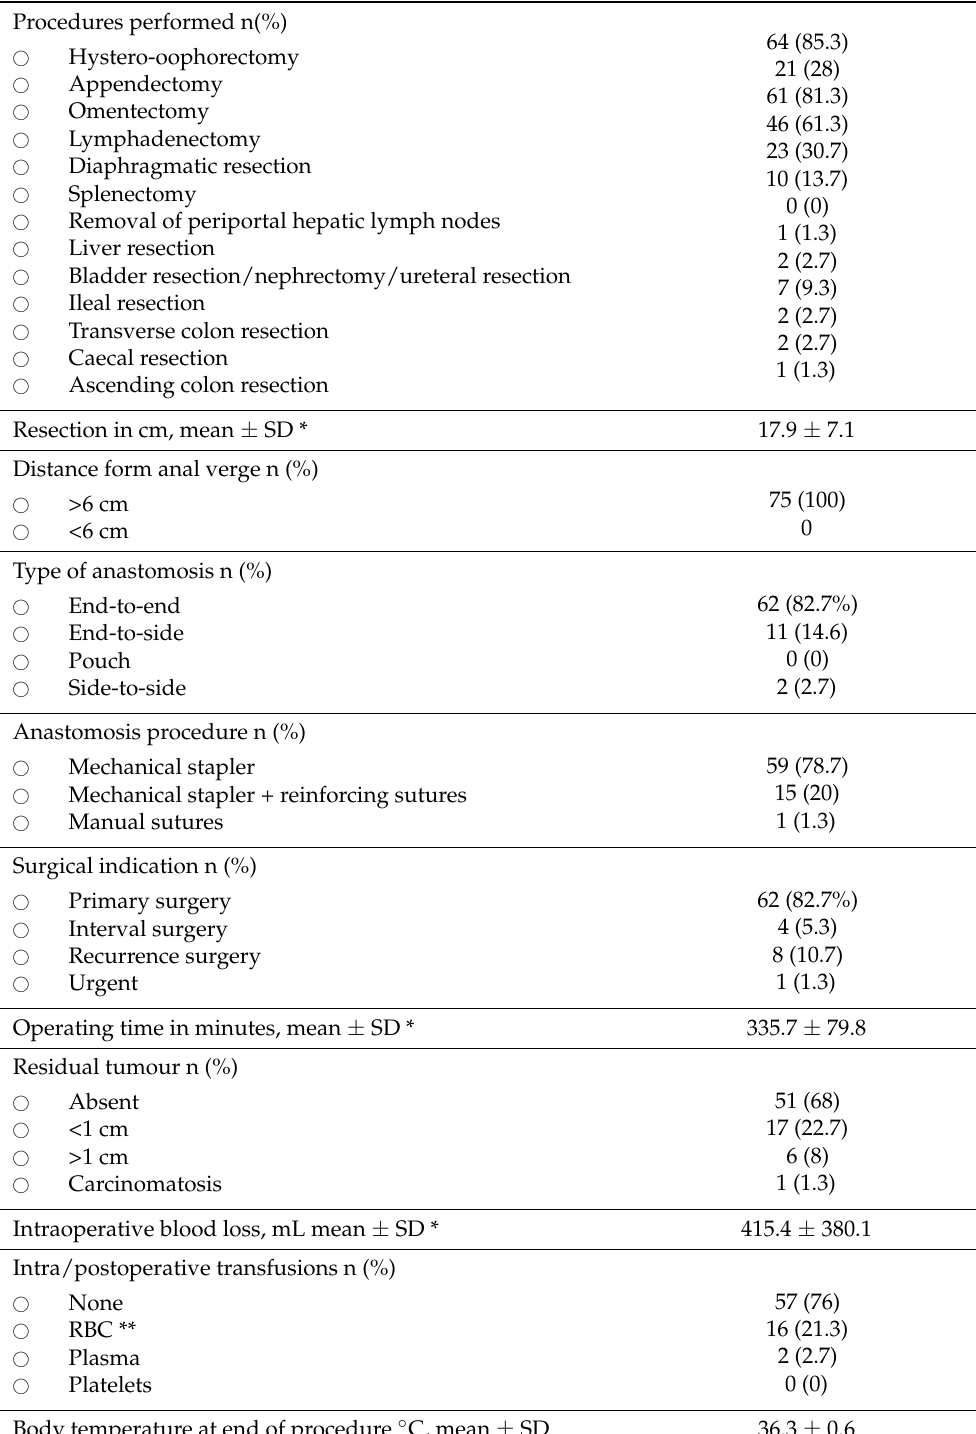
Table 3. Surgical